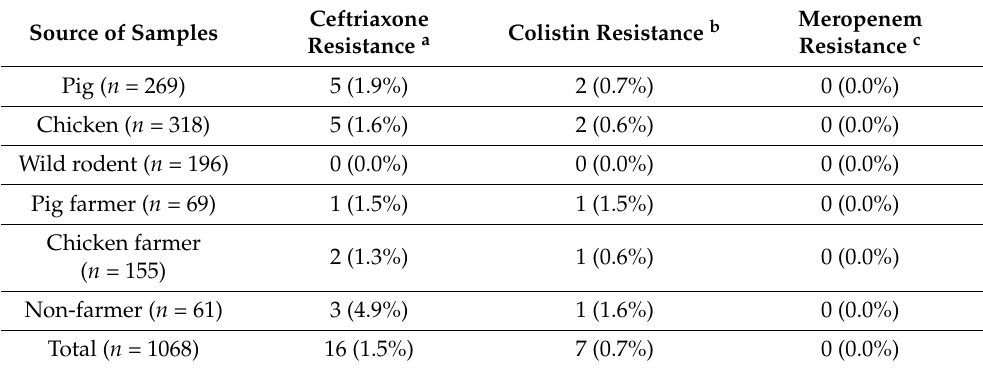
Table 3. Prevalence of ceftriaxone, colistin, and meropenem resistance in Klebsiella species isolated from samples collected from various animal and human